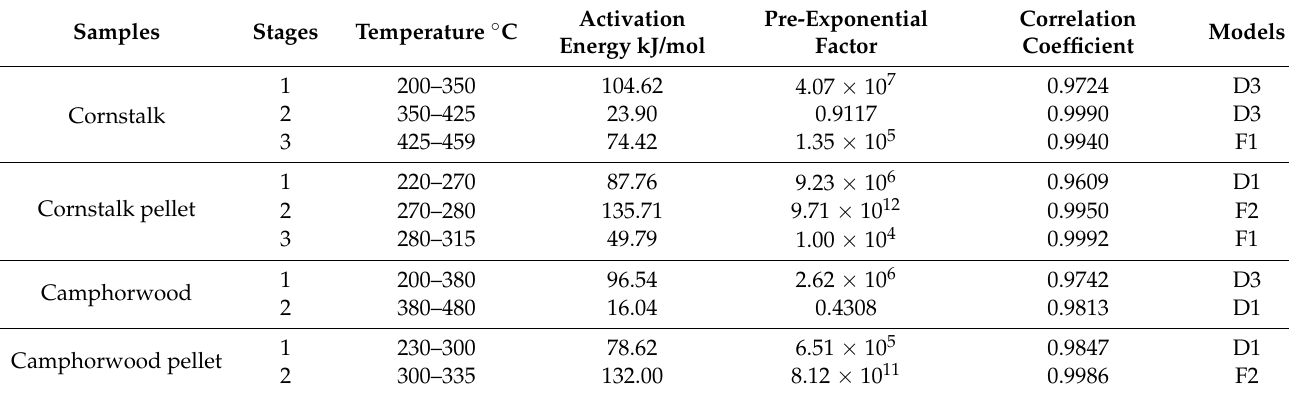
Table 4. Combustion reaction kinetics